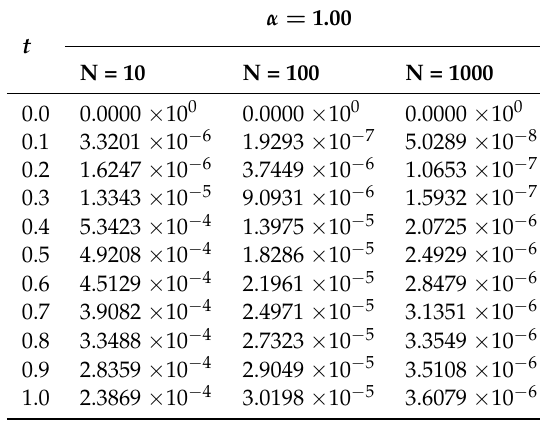
Table 12. Absolute error at each point, t in solving Example 6 by using FEAM3 when α = 1.0 for different values of N